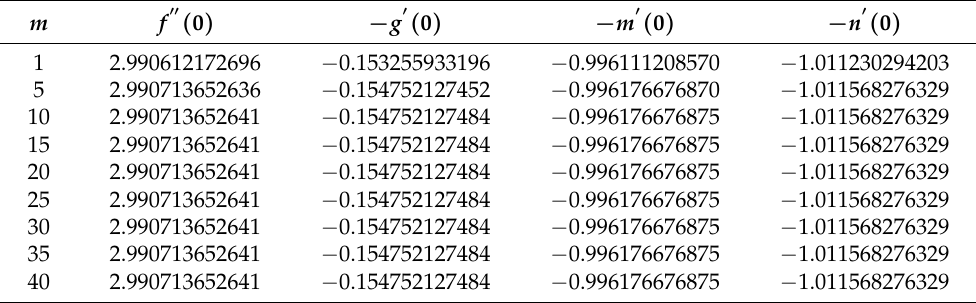
Table 4. For different orders of approximation for f (cid:48)(cid:48) ( 0 ) , − g (cid:48) ( 0 ) , − m (cid:48) ( 0 ) , and − n (cid:48) ( 0 ) , evaluating the convergence of the HAM solution with fixed values of S z = − 0.1, M x = 0.5, M y = 0.3, R m = 0.01, and S =